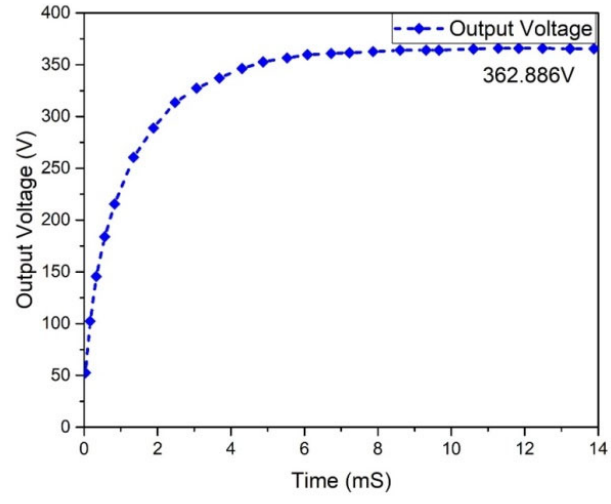
Figure 16. Results analysis of output voltage of interleaved boost converter.